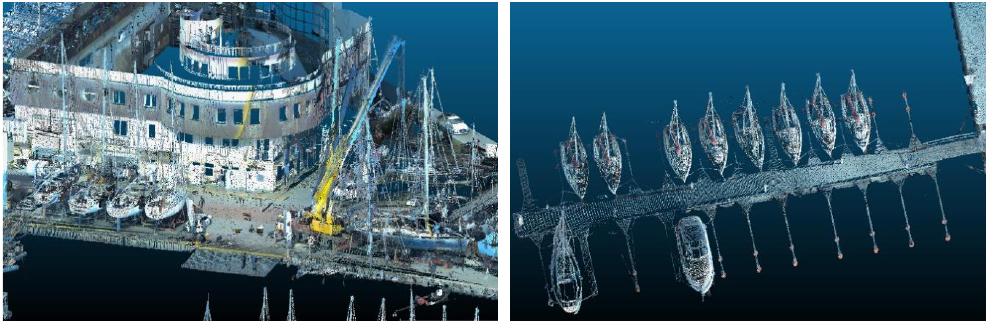
Figure 11. An image of infrastructure and the platform from TLS cloud.